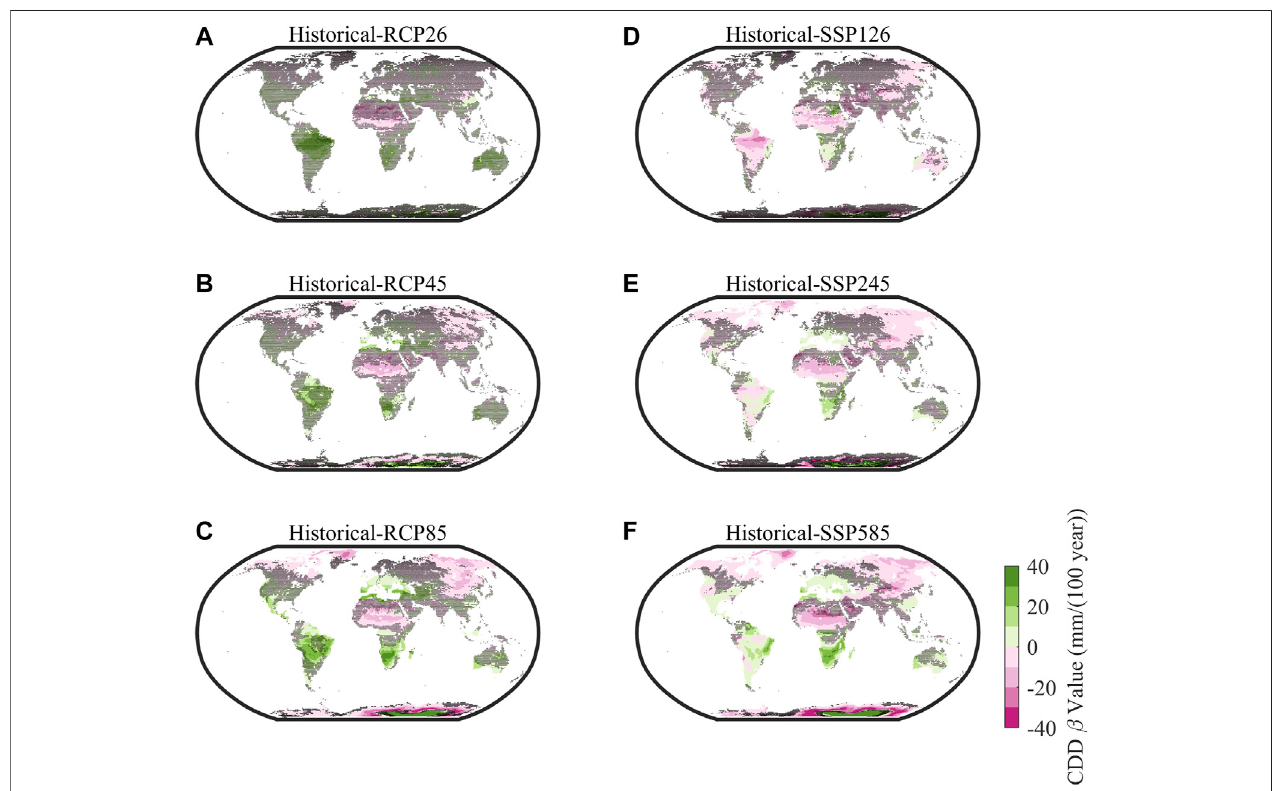
FIGURE 6 | The spatial distributions of the Sen ’ s slope estimator test ( β ) for multi-model mean CDD. It shows β values of the long series precipitation (1982 – 2100) under different future scenarios in CMIP5 (A – C) and CMIP6 (D – F) . The points represent non-signi fi cant trend at the 99% con fi dence level based on the MK test.